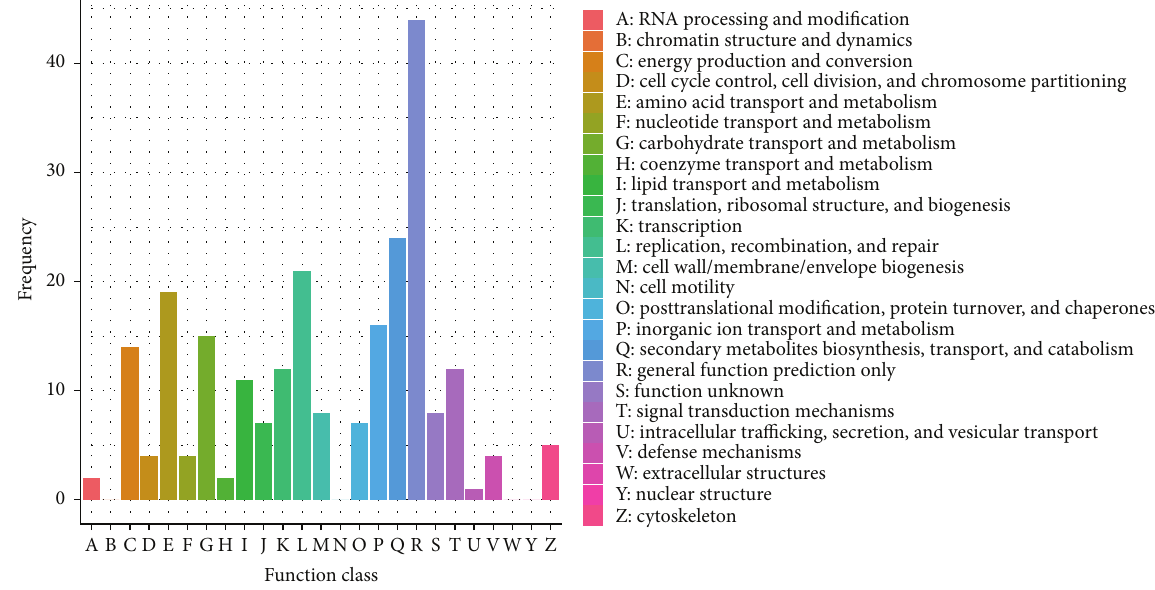
Figure 5: COG-based functional classification of DEGs between Weiduoli and